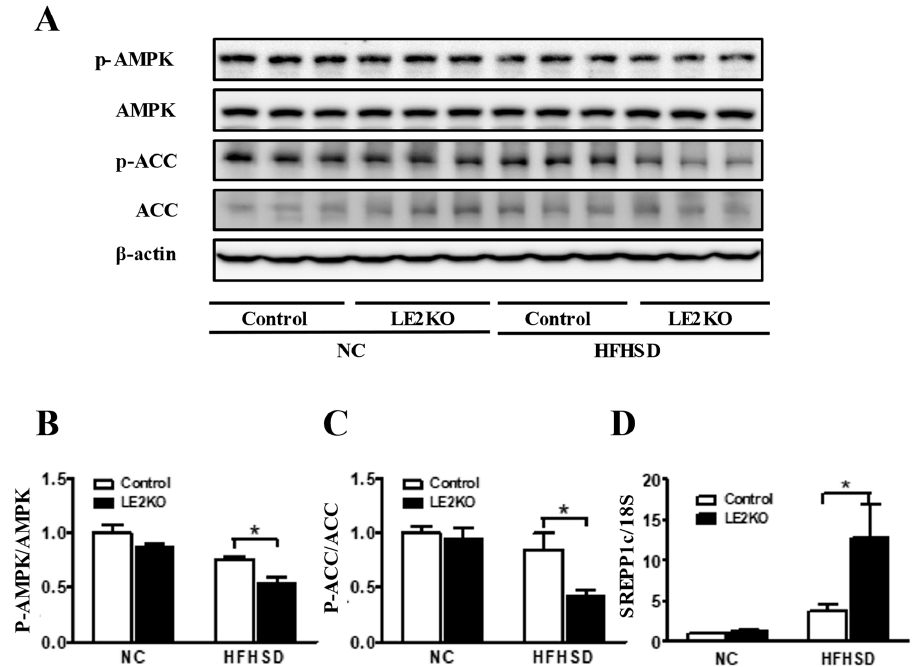
Figure 2. HFHSD-LE2KO decreased phosphorylation of AMPK/ACC and increased mRNA expres- sion of SREBP-1c in liver. ( A ) Phosphorylation of AMPK (Thr172) and ACC (Ser 79) in the livers of controls and LE2KO on NC or HFHSD, respectively ( n = 3 for each group). ( B,C ) Quantification of phosphorylation of AMPK/AMPK and phosphorylation of ACC/ACC. ( D ) mRNA expression levels of SREBP1c in the livers of control and LE2KO on NC or HFHSD, respectively ( n = 6 for each group). Error bars represent SEM; p values were determined by ANOVA (* p < 0.05, vs. HFHSD-Control). 2.3. Elevation of Serum Glucose and Insulin Levels and Insulin Resistance in Skeletal Muscle from HFHSD-LE2KO Blood fasted and fed glucose levels and serum insulin levels were higher in HFHSD- Control compared with NC-Control and were higher in HFHSD-LE2KO (Fast: NC-Con-